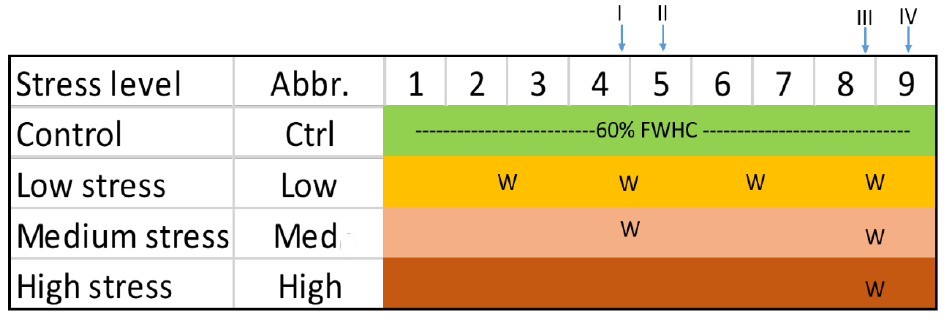
Figure 1. Scheme of soil watering and sampling during the 9 weeks of the pot experiment; Arabic numerals—week of the experiment; W—watering day; Roman numerals—sampling day. numerals—week of the experiment; W—watering day; Roman numerals—sampling